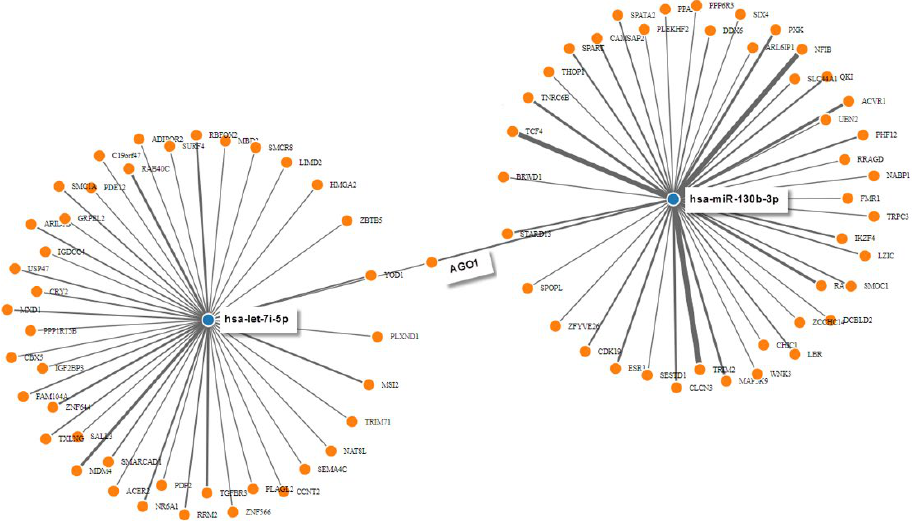
Figure 5. Predicted interaction between miRNAs and target genes. MiRNA-target gene interactions were generated manually by intersecting individual networks generated from miRWalk target gene prediction data. Only hsa-miR-130b-3p and hsa-let-7i-5p are displayed for clarity. Blue dots represent miRNAs that interact with their target genes, which are represented by orange dots.